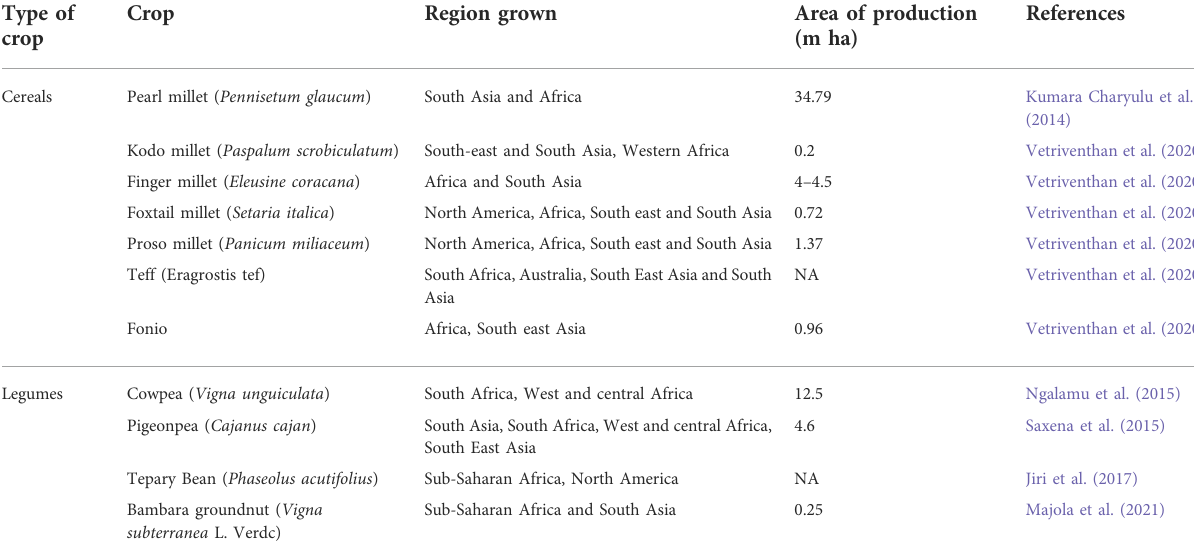
Table: Major underutilized crops and their area covered under dry regions in the